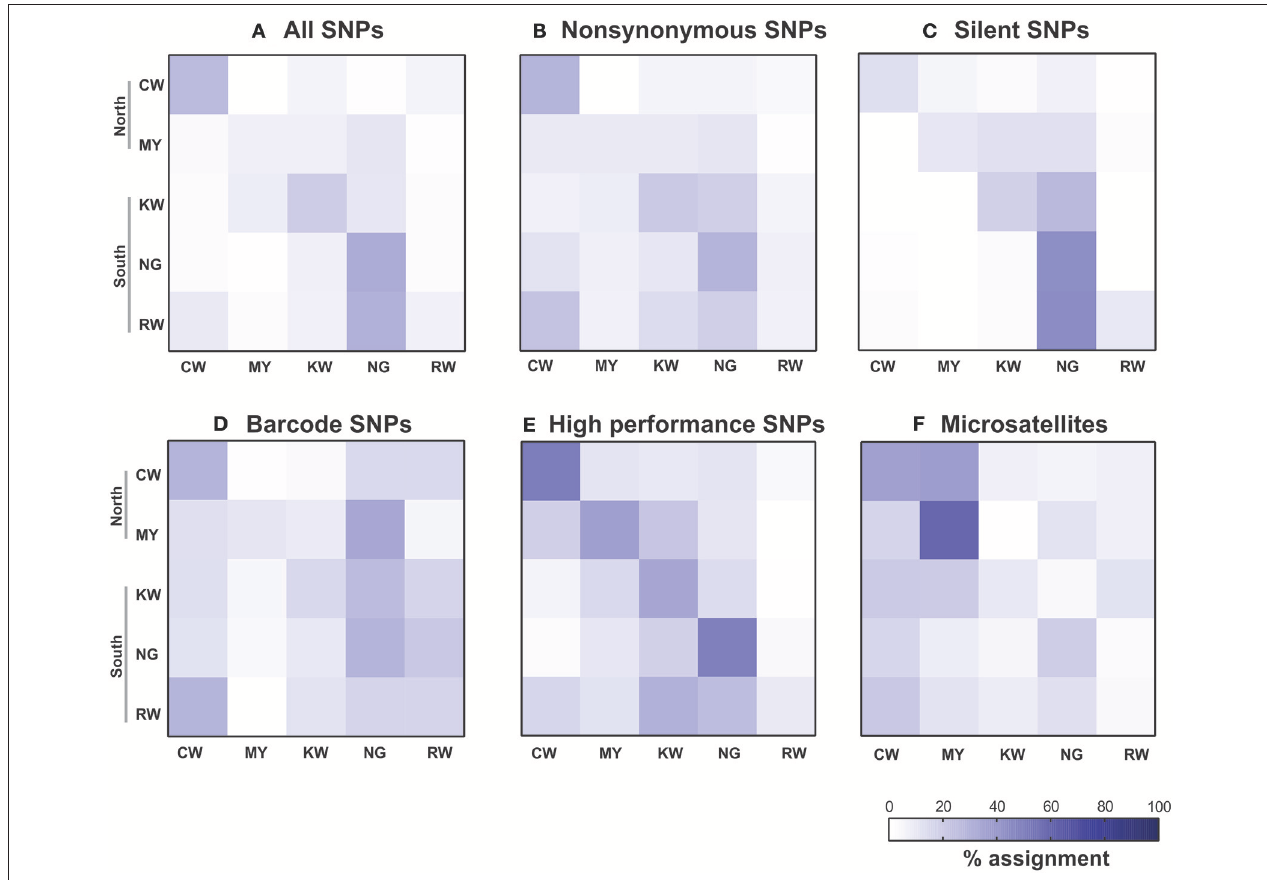
FIGURE 4 | Assignment matrix heatmaps of the SNP datasets (A–E) and microsatellites (F) indicating percentage assignment. Color intensity reflects the probability of an individual from a reference population (rows) being assigned to a given population (columns). The darkest shade indicates the highest probability and the lightest shade indicates the lowest. CW, Chwele; MY, Mayanja; KW, Kanyawegi; NG, Ngiya and RW,